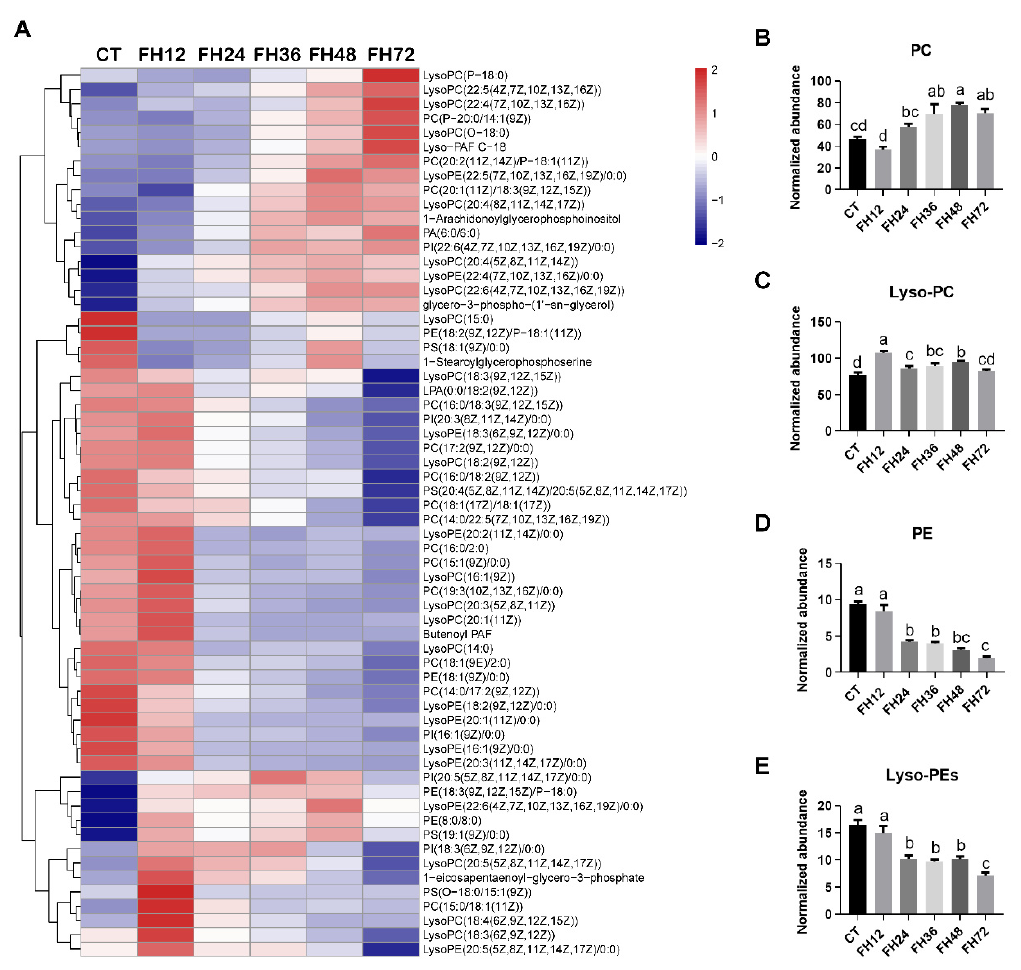
Figure 7. Effect of fasting duration on the serum glycerophospholipid metabolome. ( A ) Heatmap of glycerophospholipids during the different fasting duration. Changes in PC ( B ), Lyso-PC ( C ), PE ( D ), and Lyso-PE ( E ) in response to fasting. Data are analyzed by ANOVA and multiple comparisons using the Duncan correction. Values are means ± SEM, n = 8. Labeled means without a common letter are significantly different, p ≤ 0.05. CT—birds fed ad libitum; FH12—birds fasted for 12 h;